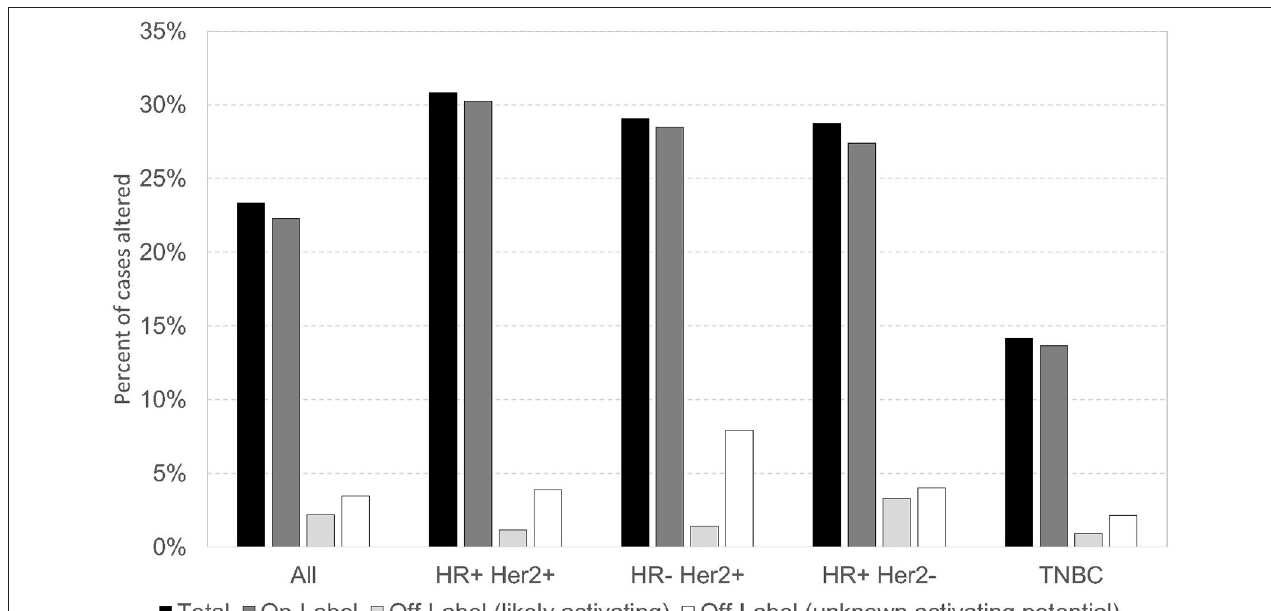
FIGURE 3 | Prevalence of alpelisib On/Off Label PIK3CA mutations across breast cancer